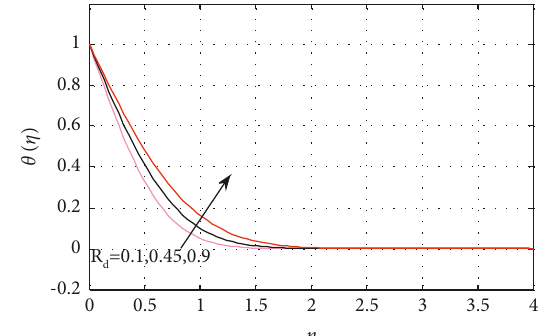
Figure 6: Impact of the radiation parameter on the temperature profile using A � 1 , v � 0 . 4 , Gr β 2